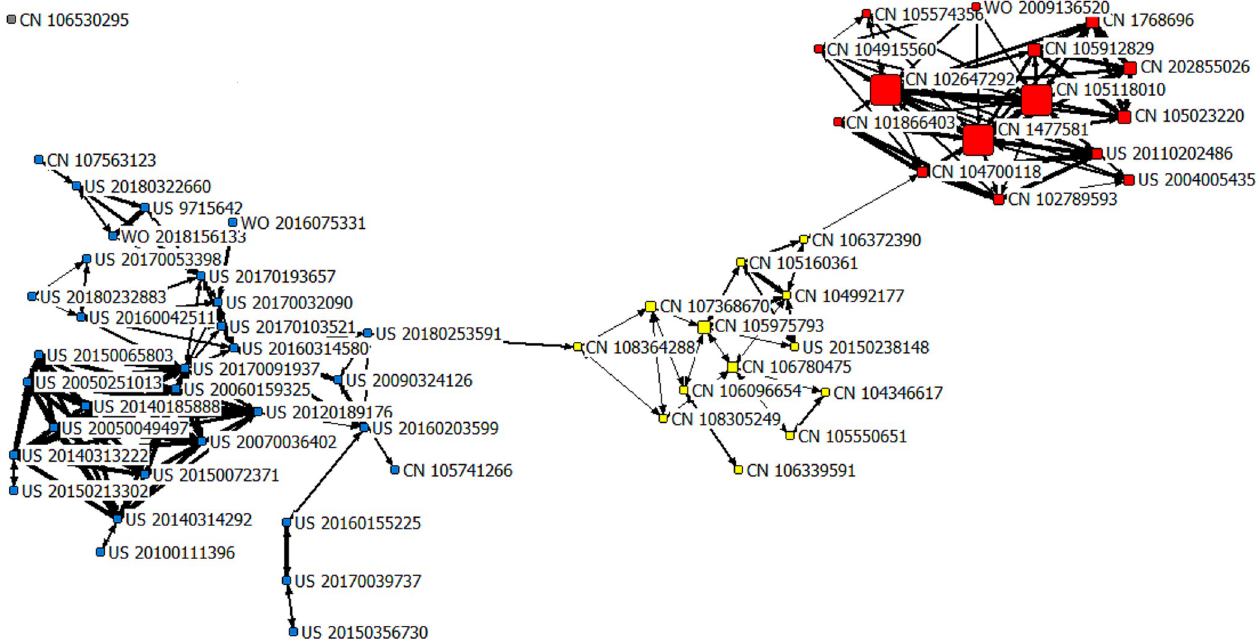
Fig 5. The patent co-citation network of the field of AI-assisted pathology from 2016 to 2021. Note: The subnetwork 1 is with the yellow nodes, the subnetwork 2 with the red nodes, and the subnetwork 3 with the blue nodes.